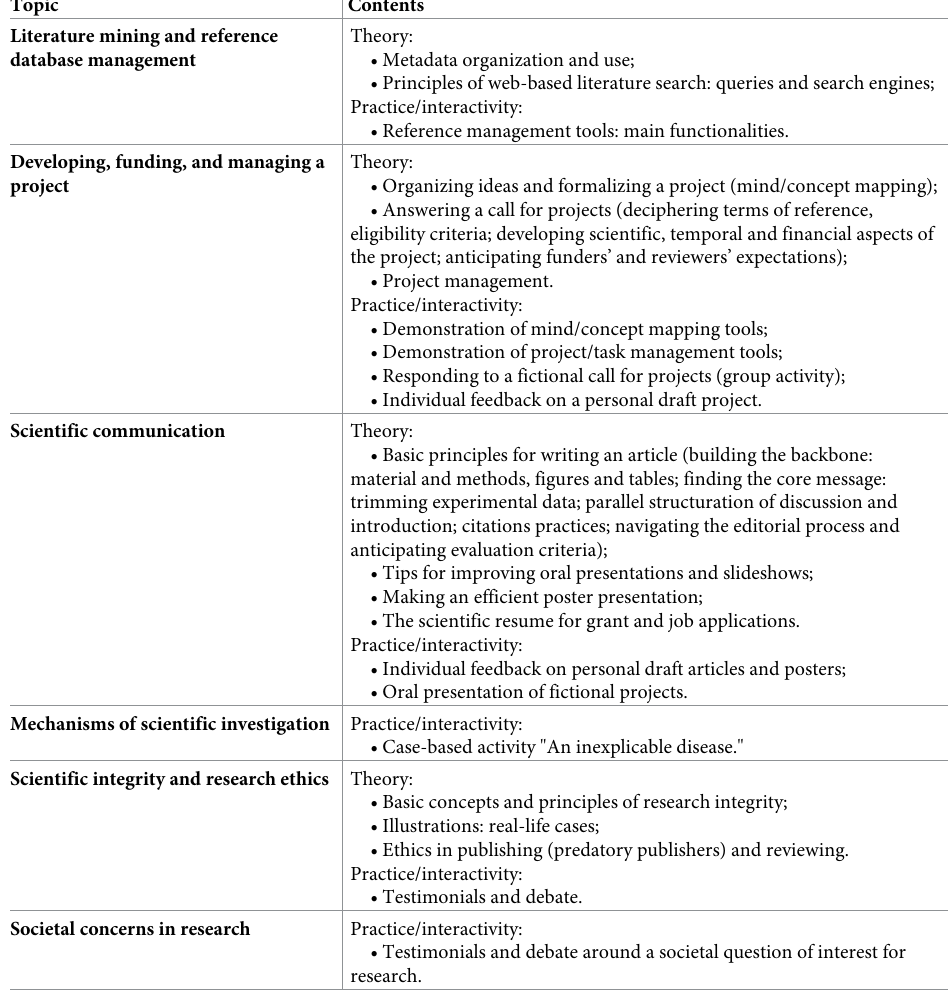
Table 1. Program of the MooSciTIC summer